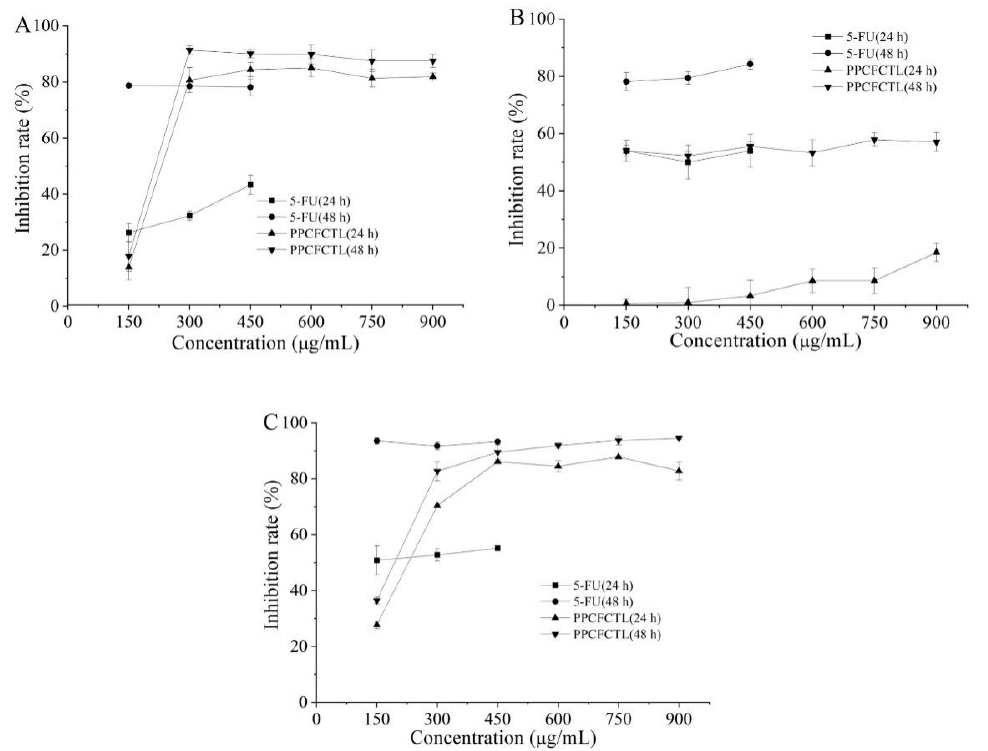
Figure 3. Antiproliferative activities of PPCFCTL: ( A ) Human cervical cancer HeLa cell, ( B ) Human hepatoma HepG2 cell, ( C ) Human lung cancer NCI-H460 cell. Data represent means of three independent experiments (mean ± SD).